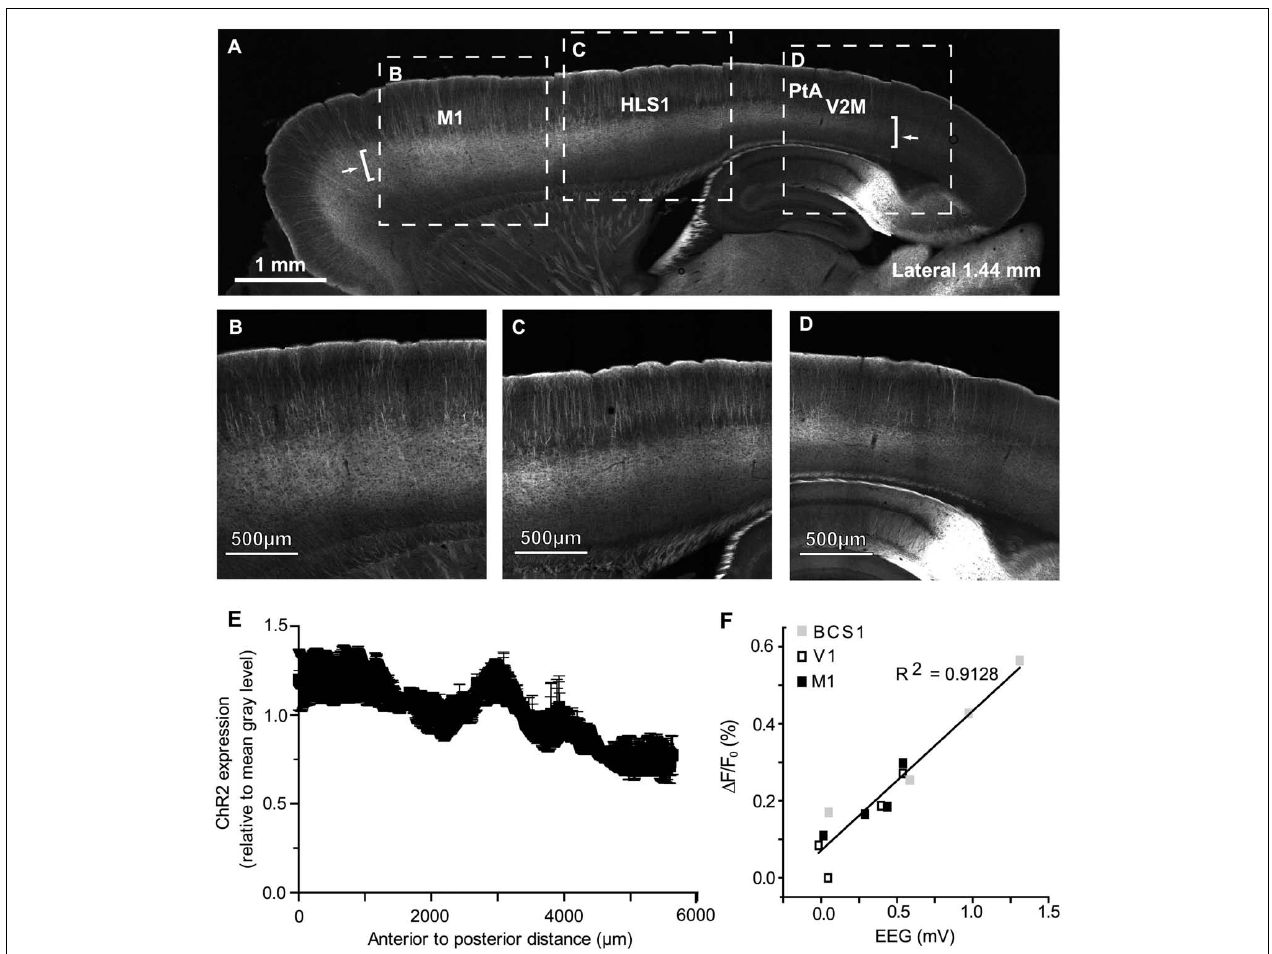
in (A) . (C) High magnification image from the section shown in (A) . (D) High magnification image from the posterior end of the section shown in (A) . (E) Anterior to posterior fluorescence profile of average ChR2 expression, quantified relative to mean gray value per animal. Data shown as mean gray value ± SEM ( n = 3 animals). (F) Relationship betweenVSD signal strength and EEG depolarization following photostimulation at different ROIs within a single representative animal. PeakVSD responses are plotted against peak EEG depolarizations following photostimulation at different